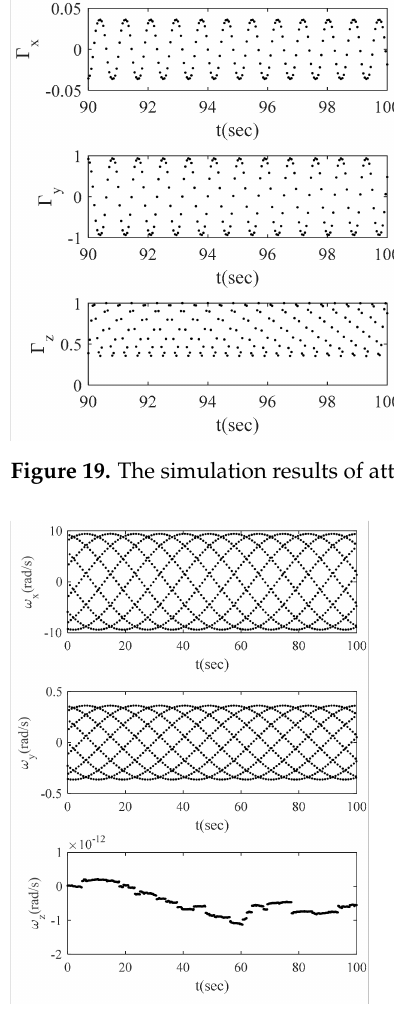
Figure 20. The angular velocity results under reduced